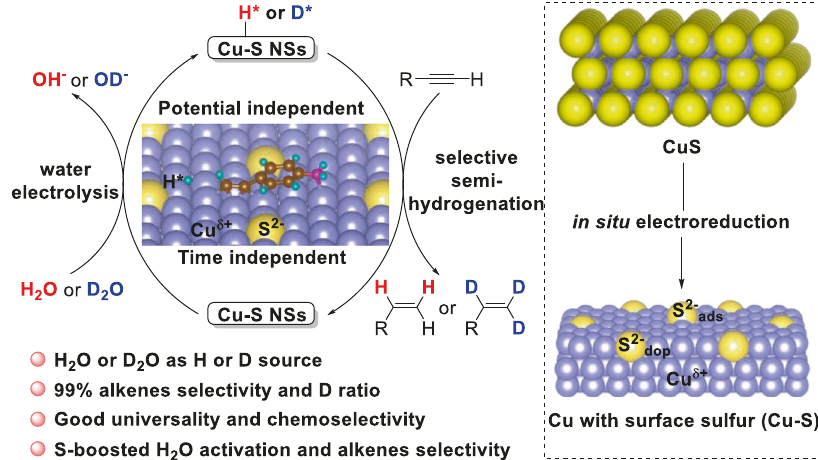
Fig. 1 A schematic illustration of the semi-hydrogenation strategy. Electrocatalytic transfer semi-hydrogenation of alkynes with H 2 O to corresponding alkenes over in situ-formed Cu with surface sulfur doping and adsorption (Cu-S).